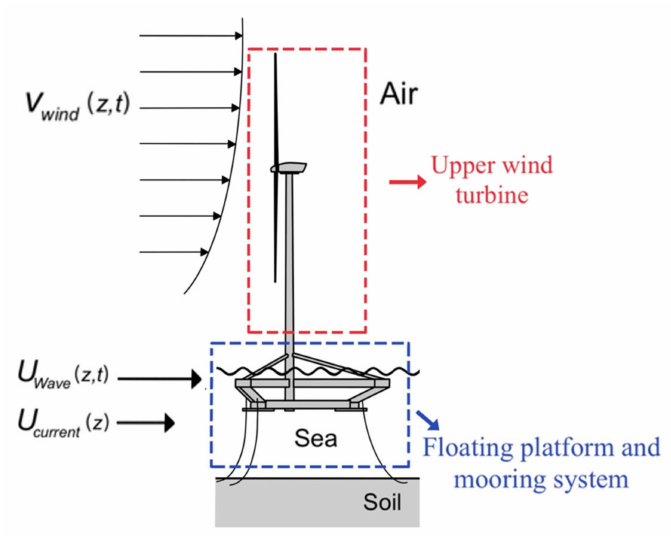
Figure 4. Novel floating wind turbine.